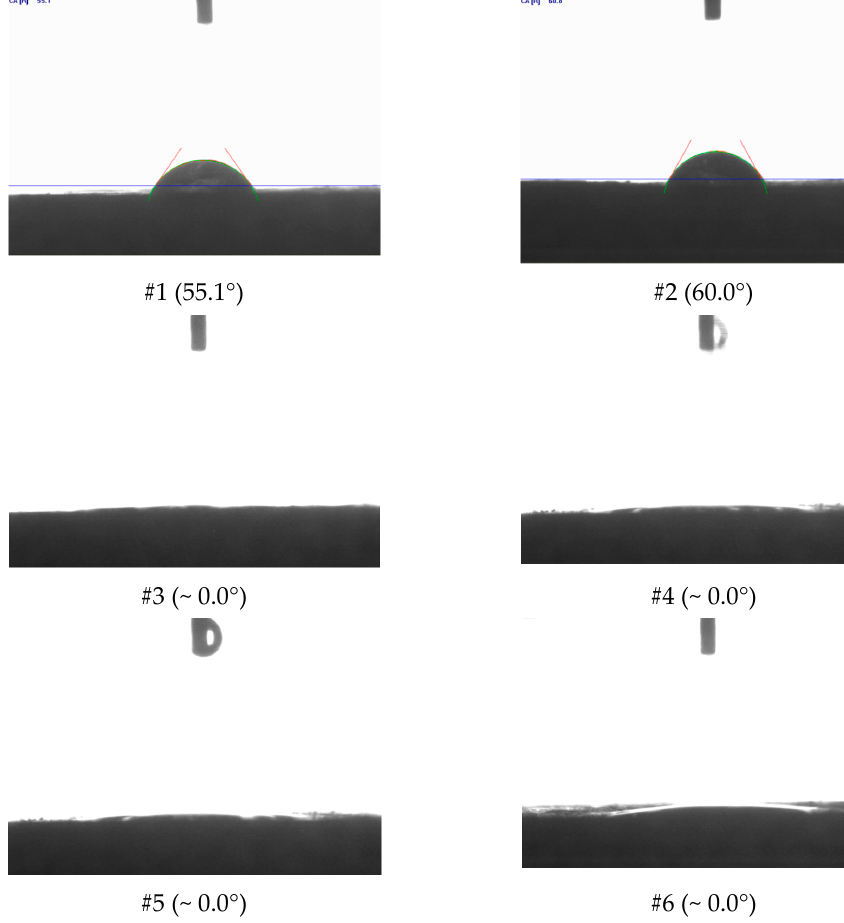
Figure 15. Contact angle in Indiana limestone measured with DW ( distilled water) after surface treatment with SA-1.54 wt. % HCl (#1), SA-15.00 wt. % HCl (#2), SSA-1.54 wt. % HCl (#3), SSA-15.00 wt. % HCl (#4), ANS1-1.54 wt. % HCl (#5) and ANS1-15.00 wt. % HCl (#6).